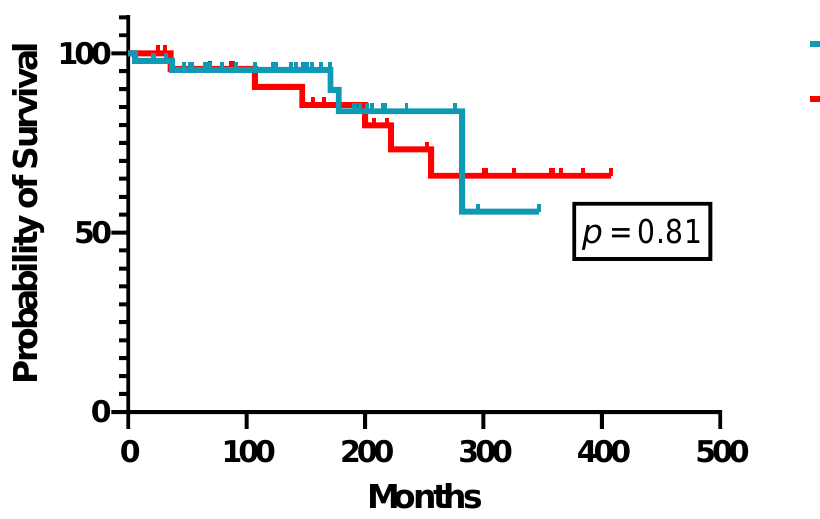
Figure 4. Progression-free survival after first-line therapy ( n = 66).